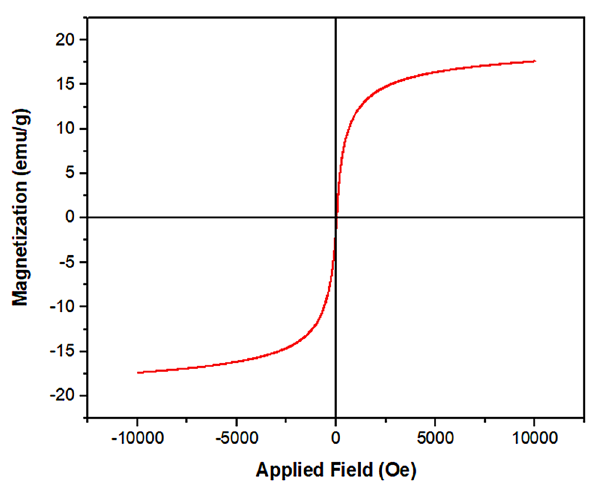
Figure 4. VSM of the MS/Ag 2 CO 3